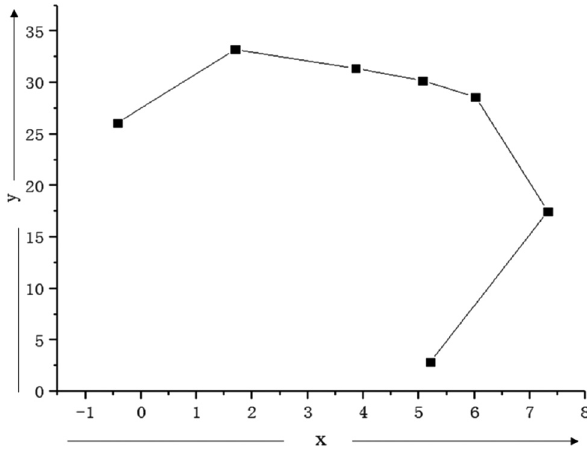
Figure 5: Change of ship movement and position under the dynamic positioning control model.